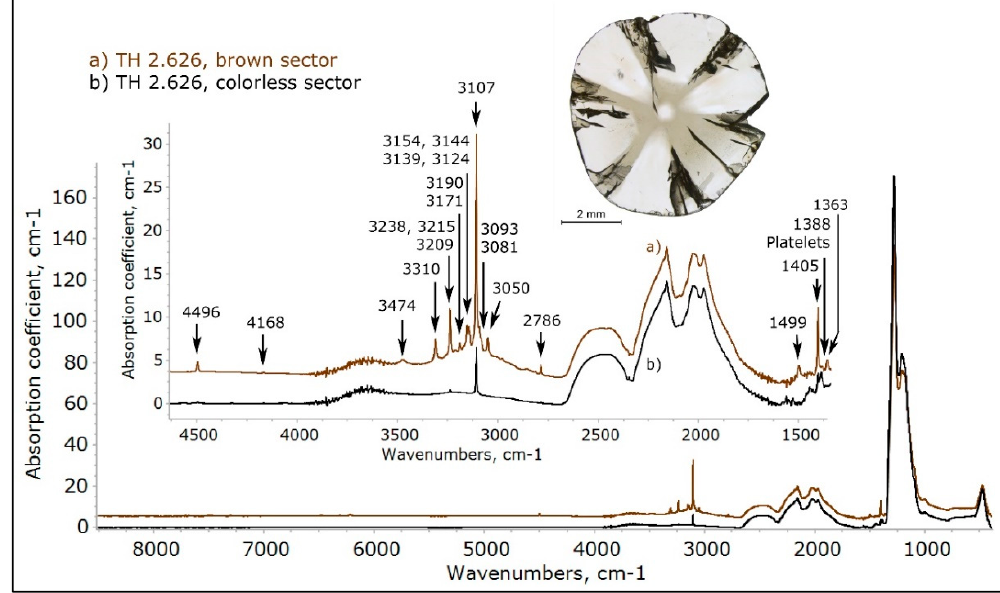
Figure 16. The normalized IR spectra of the brown (trace a) and the colorless (trace b) sectors of a NDR mixed growth hydrogen- and nitrogen-rich type IaA>>B diamond (TH 2.626). While the spectrum of the colorless sector shows only comparatively weak H related peaks at the classical positions 3107/1405 cm − 1 and 3238 cm − 1 , the H- related features in the brown sectors are significantly more complex and the 3107/1405 and 3238 cm − 1 lines are distinctly stronger; the 3107 cm − 1 line is 5 times stronger in the brown than in the colorless sector. The NIR peaks recorded for the other hydrogen-rich diamond were very weak in the spectrum of this sample and undetectable at RT. The spectra have been shifted vertically for clarity.